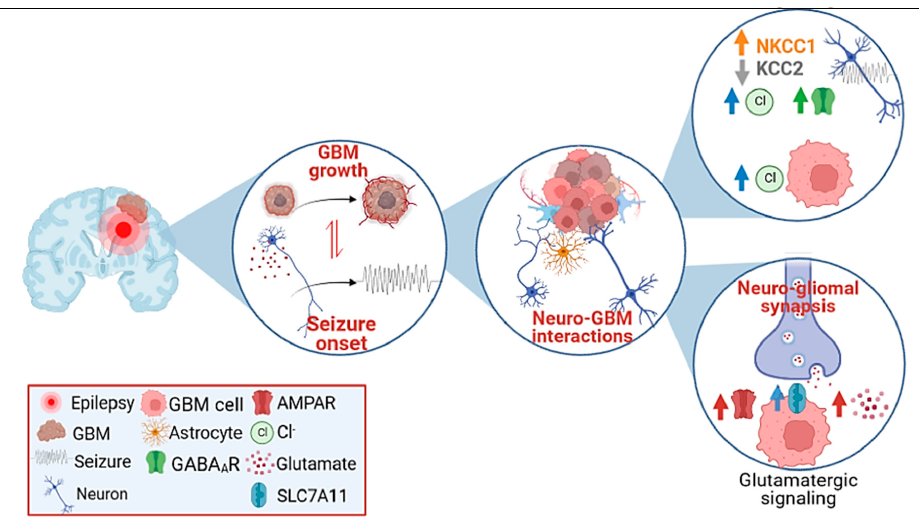
Figure 1. Neuro ‐ glioma interplay: role in glioblastoma (GBM) progression and in GBM ‐ related epilepsy. (Details of the molecular processes are described in the text). The schematic diagram